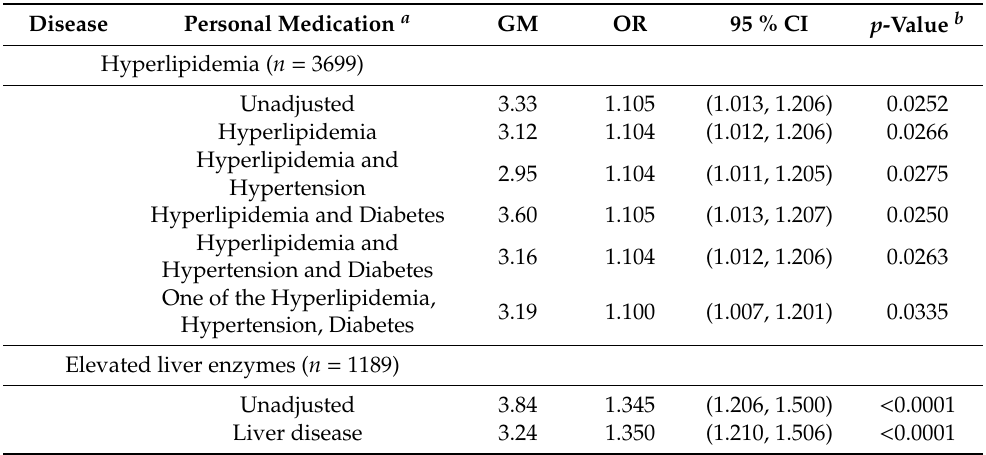
Table 5. The relationships between blood Hg and hyperlipidemia and elevated liver enzymes. Disease Personal Medication a GM OR 95 % CI p -Value b Hyperlipidemia ( n = 3699) Unadjusted